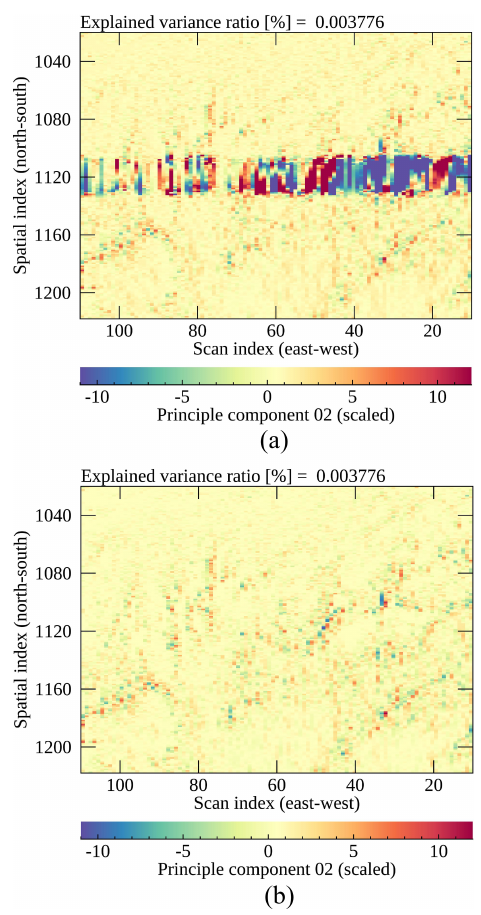
Figure 10. The second PC scores of (a) GEMS radiances and (b) ML radiances on the target area for Defect 3. The PC is scaled for clarity of